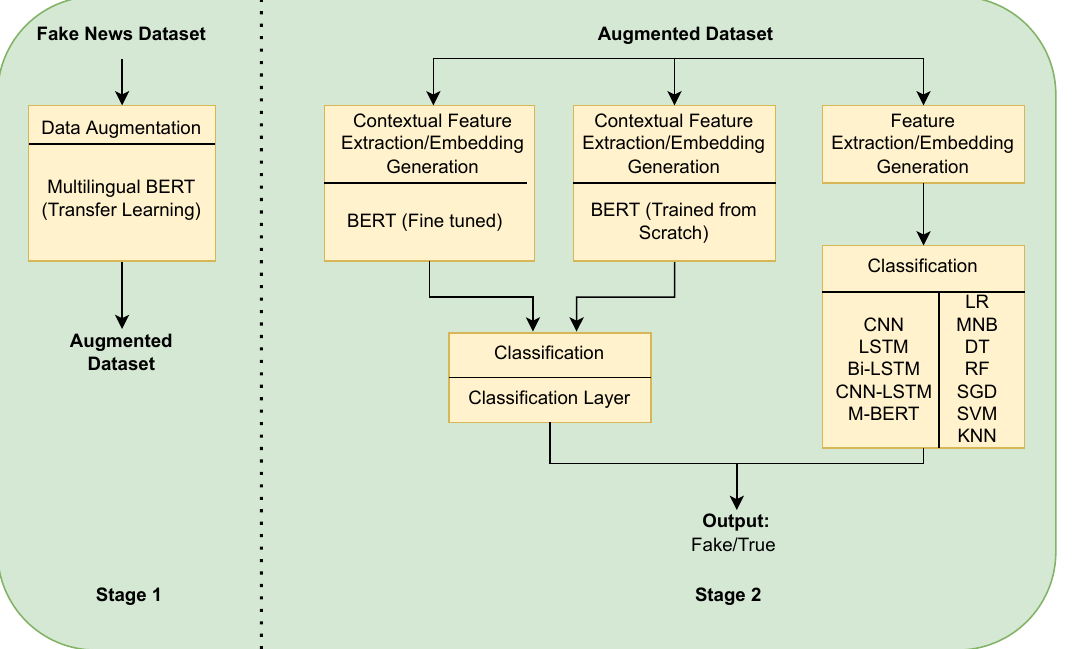
Figure 1. An abstract view of our fake news detection